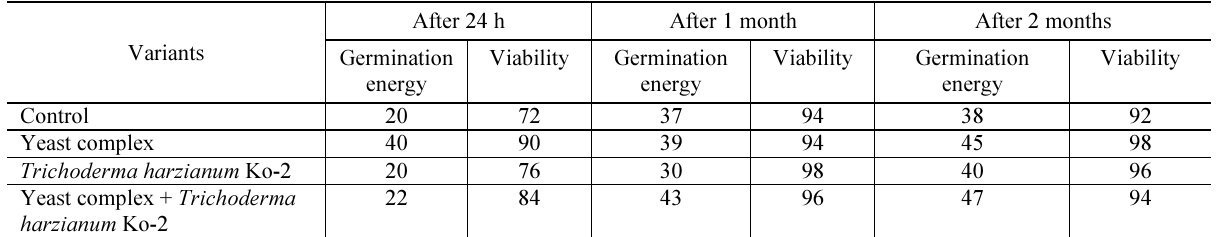
Table 6. The effect of MEA waste in peat with inoculated microorganisms on rye germination energy and viability ( % ) during the experiment